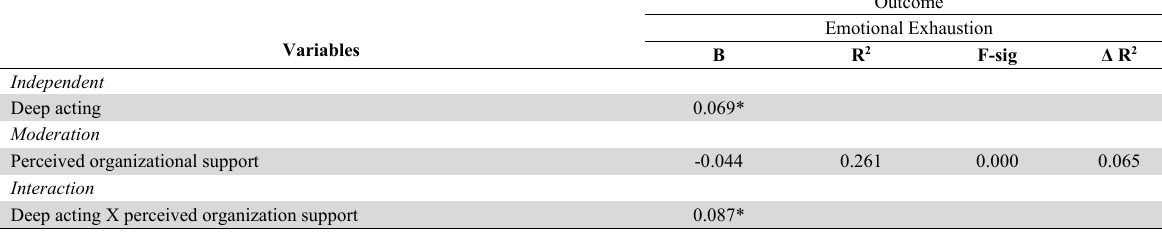
Moderation effect of perceived organizational support on deep acting and emotional exhaustion